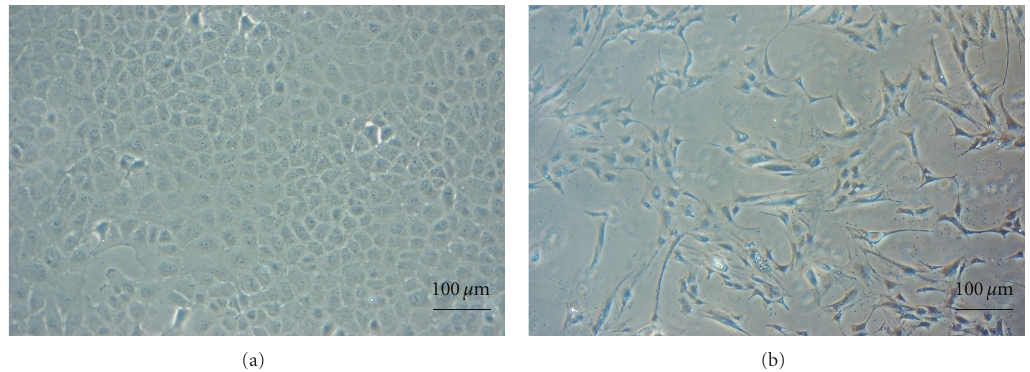
Figure 2: (a) Corneal endothelial and (b) trabecular meshwork cells cultured in vitro